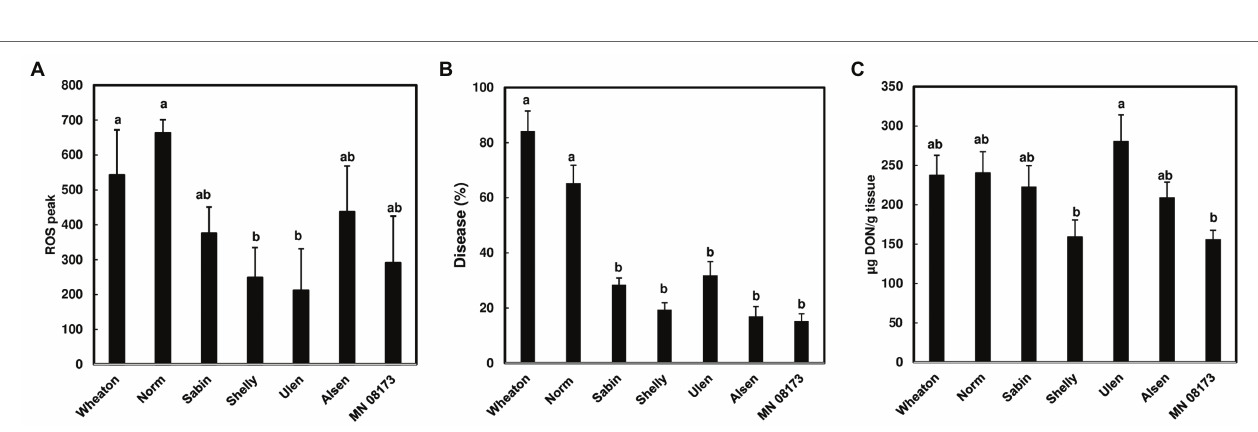
FIGURE 3 | ROS level, FHB severity, and DON content in wheat varieties. (A) ROS peak in wheat rachis nodes. ROS were monitored using a chemiluminescence assay with L012 as a substrate. Signals (RLU) were recorded for 60 min after treatment. Chitin (100 μ g/ml) was used. The data represent means ± standard error ( n = 36) of the maximum luminescence for each variety; (B) FHB severity. Point inoculations (10 μ l of 10 5 conidia/ml) were performed on wheat florets with F. graminearum strain PH-1. FHB was scored as the percentage of spikelets infected at 21 days post-inoculation (dpi). Bars represent the average percentages and standard error of infected spikelets at 21 dpi for each variety. The mean for each variety was analyzed independently and compared by one-way ANOVA and Tukey’s honestly significant difference (HSD) post-hoc test using JMP15 ( n = 10–20; p < .05); (C) DON content. DON was extracted from one or two infected spikelets from each head at 21 dpi and analyzed by GC/MS. The mean of DON for each variety was calculated and compared by one-way ANOVA and Tukey’s HSD post-hoc test using JMP15 ( n = 10–20; p < .05). Different letters indicate significant